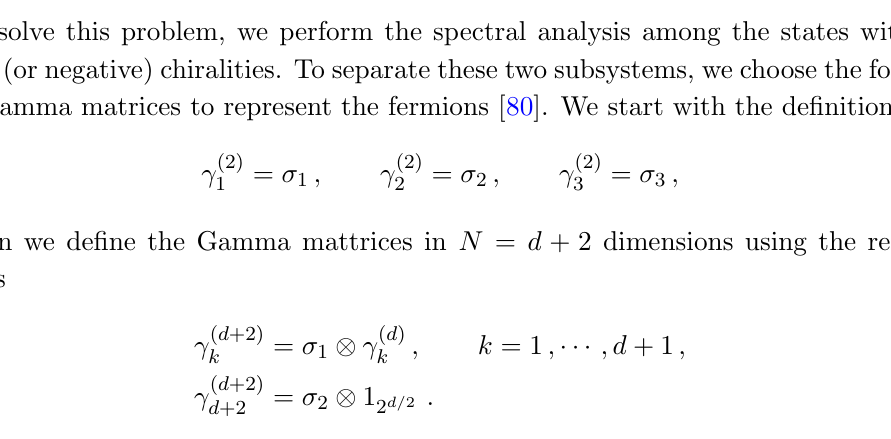
Figure 13 . The hamiltonian of the SYK model in the block diagonal